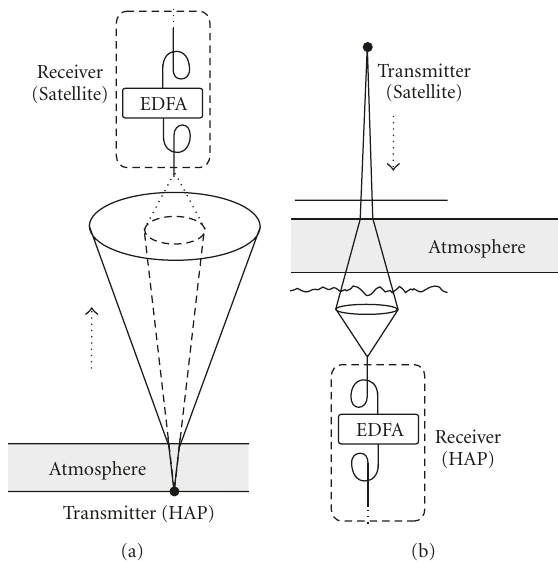
Figure 3: (a) Uplink: Negligible phasefront disturbance, large beam spreading. (b) Downlink: Negligible beam spread, large phasefront disturbance over receiving aperture.